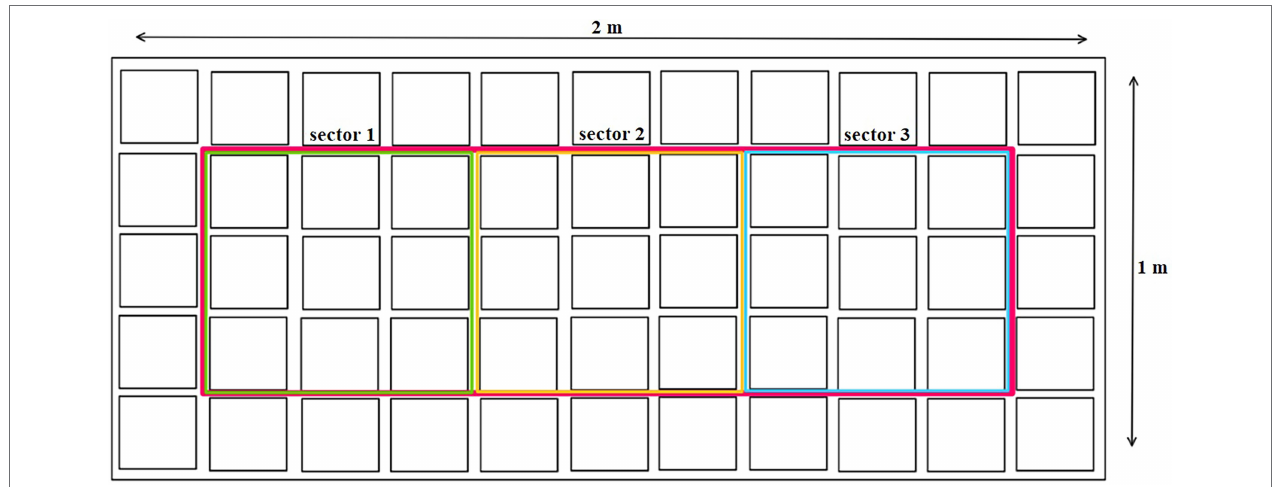
FIGURE 1 | Plant sampling